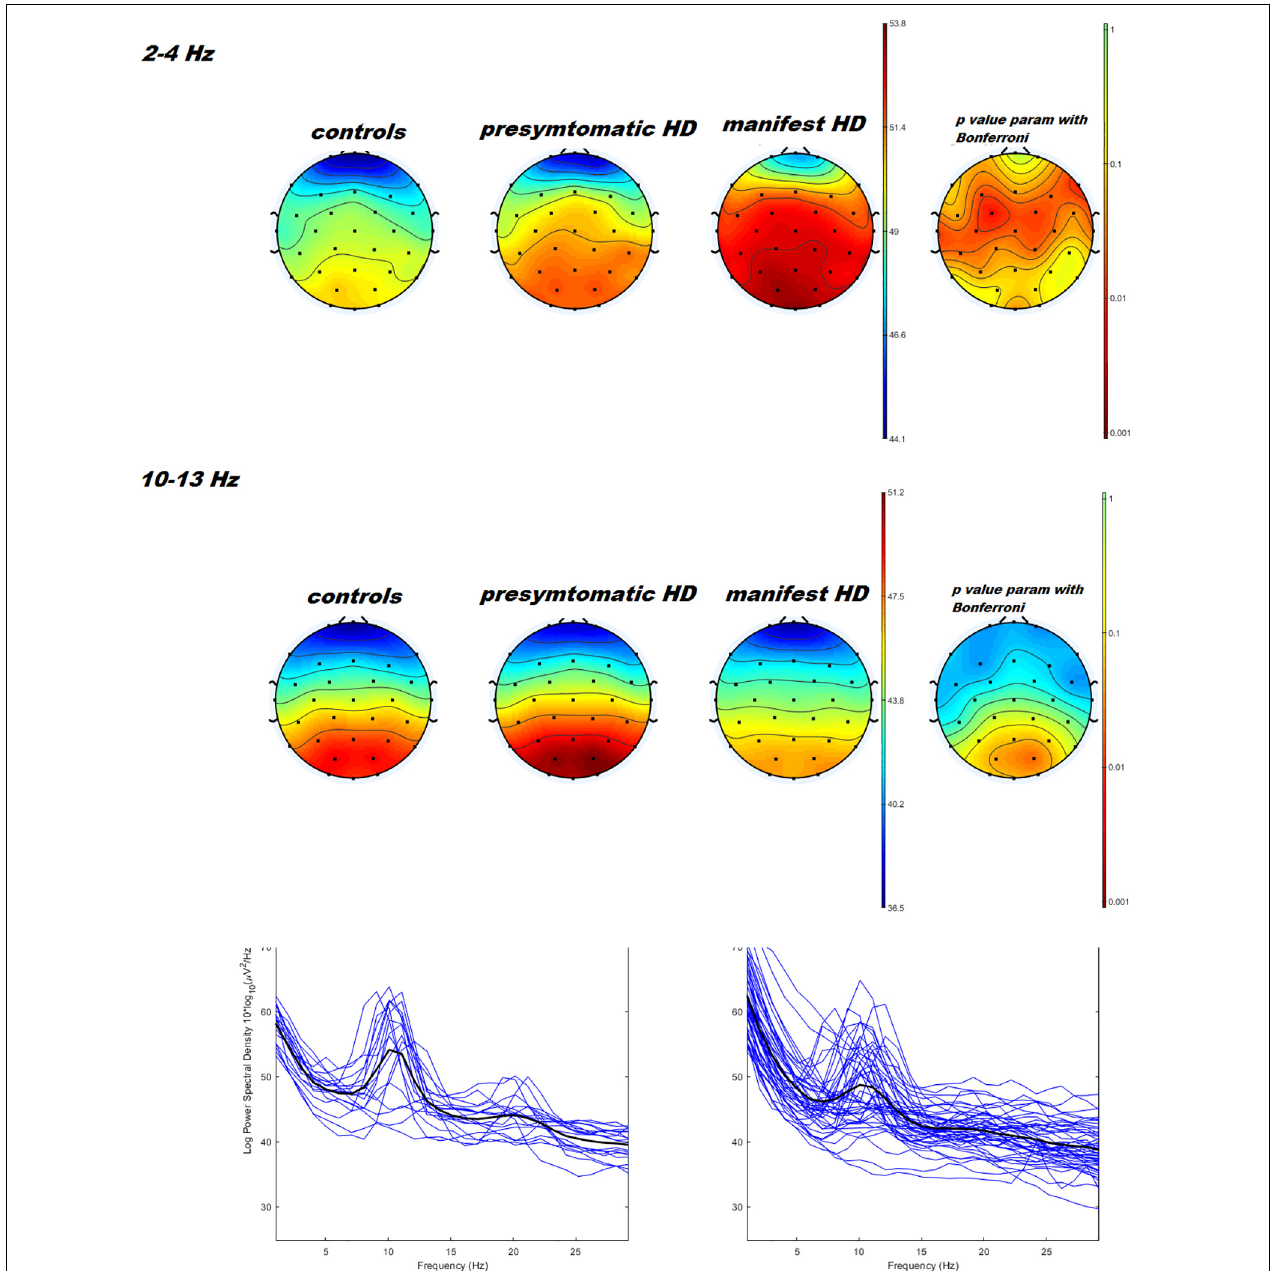
FIGURE 1 | Topographical maps and statistical analysis of power density in delta e alpha band. On the left side, results of three ways ANOVA with controls vs. pHD vs. mHD is reported. P values < 0.05 are represented in orange and red colors. The two ways ANOVA test comparing pHD vs. mHD and pHD vs. controls was not significant. At the bottom of the figure, example of power spectra averaged across O1, O2, and Oz channels in pHD and mHD are